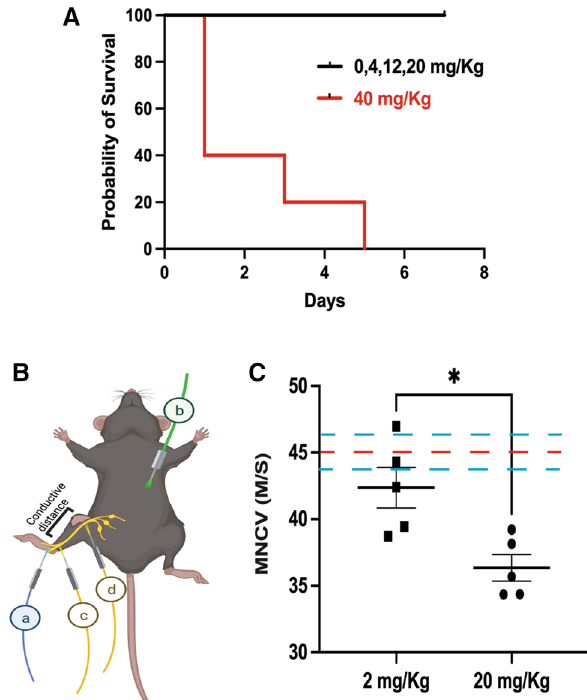
Fig. 1 Acute exposure of high dose systemic oxaliplatin can cause peripheral neuropathy in mice. A Kaplan Meier survival analysis of C57BL/6 harboring orthotopic pancreatic tumors exposed to different systemic (IP) doses of oxaliplatin shows the dose of 40 mg/kg caus- ing acute toxicity and death in this model. B Motor Nerve Conduction Velocity (MNCV) measurement shows a reduction of nerve func- tion. Schematic of the MNCV experiment on mice showing the placement of recording electrode in the intraosseous muscles electrode ( a ), grounding electrode b and the stimulating electrodes at the ankle c and sciatic notch. Time taken for the nerve impulse to travel c to d was measured to calculate the MNCV. C MNCV data represented as mean±SEM of 5 mice per group of systemic oxaliplatin delivery with each data point representing the mean value from 3 repeated measurements per mouse. Red dotted line represents the average MNCV of untreated mice with 95% confidence intervals (blue dotted lines) reported elsewhere